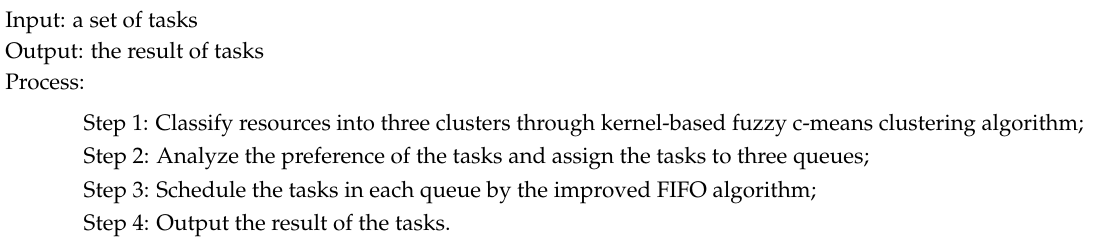
Figure 2. Procedure of Algorithm 1. VM = virtual machine. Algorithm 1. The main process of the proposed algorithm